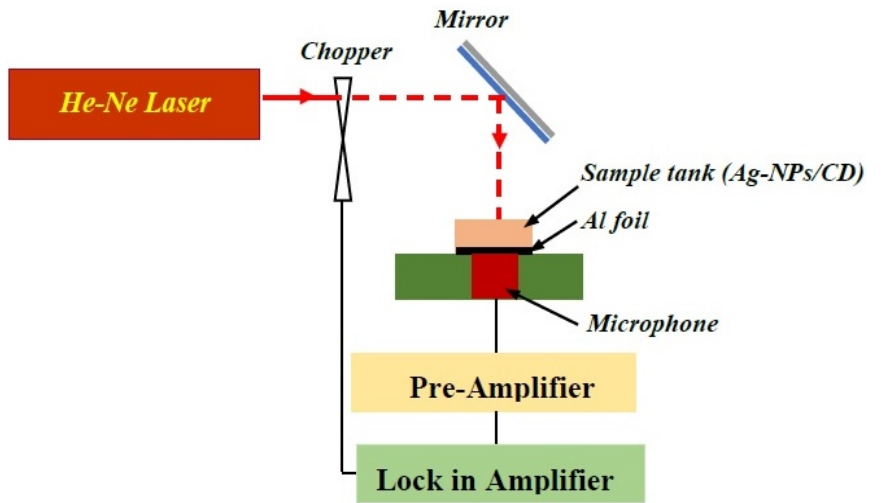
Figure 14. The photoacoustic setup contains a He–Ne laser, a chopper, mirror, sample tank, Al foil, microphone, pre-amplifier and lock-in amplifier.